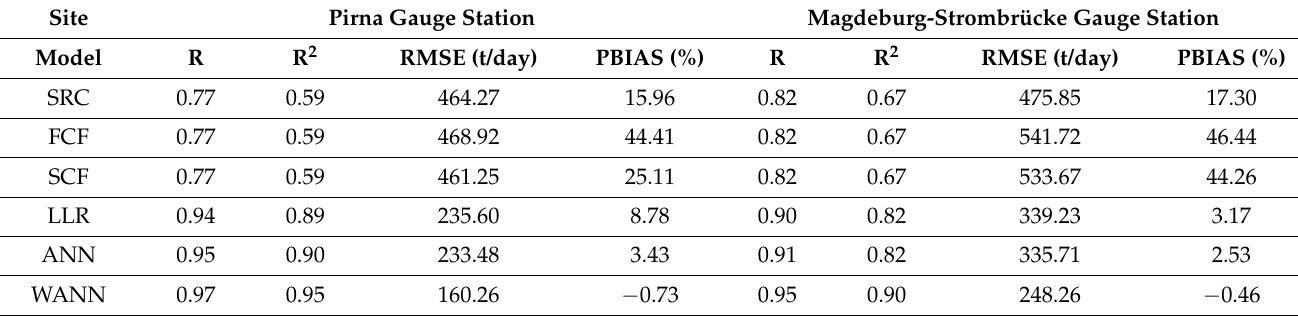
Table 9. Comparison of best models for the prediction of daily SSL.